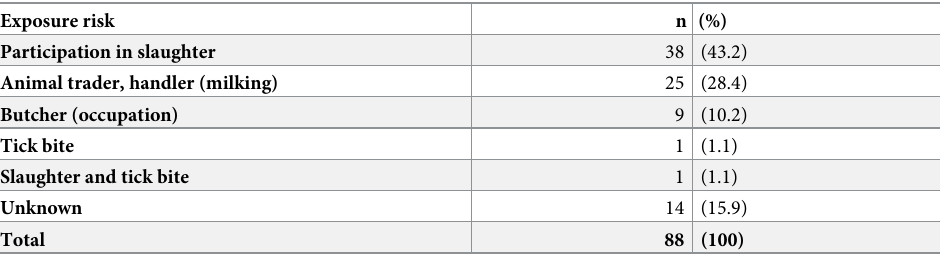
Table 1. Exposure risk factors for all 88